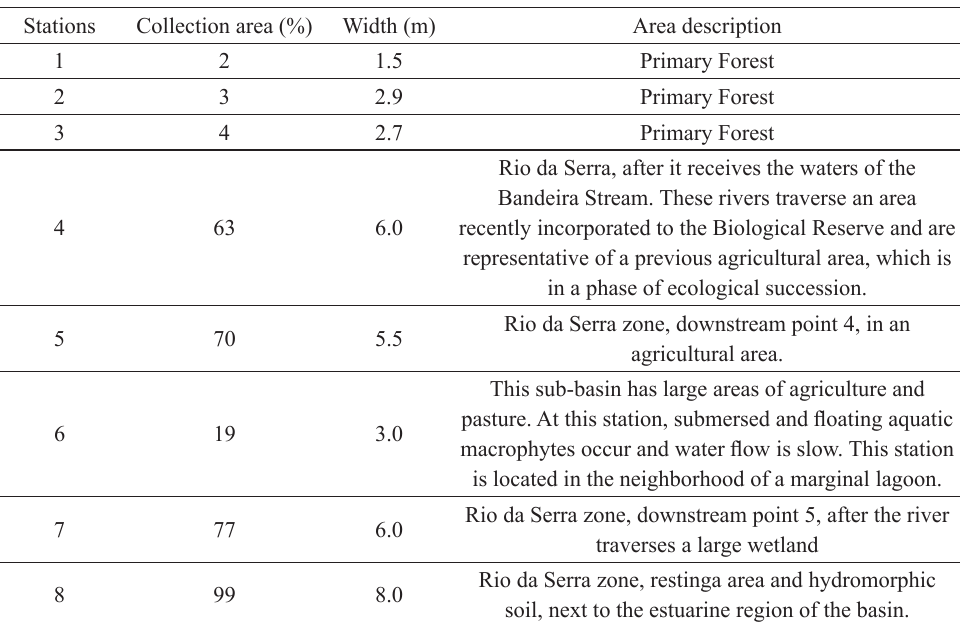
Description of the sampling stations with percentages of their collection areas and maximum river